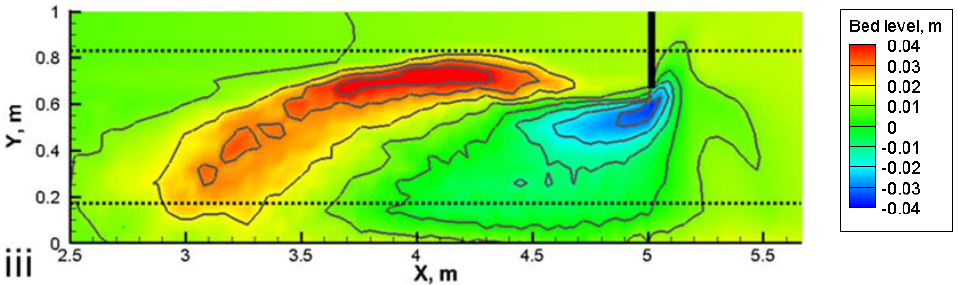
Figure 9. Measured and simulated equilibrium bed levels at Q = 58 L/s (top: measured, i: vR; ii: Wilcock and Crowe formula; iii: combined approach).